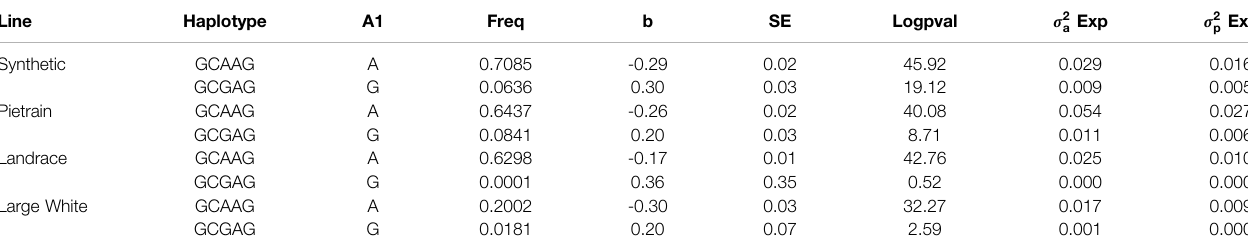
TABLE 11 | Frequency of core haplotype and ancient wild-type core haplotype per line and effects on backfat.